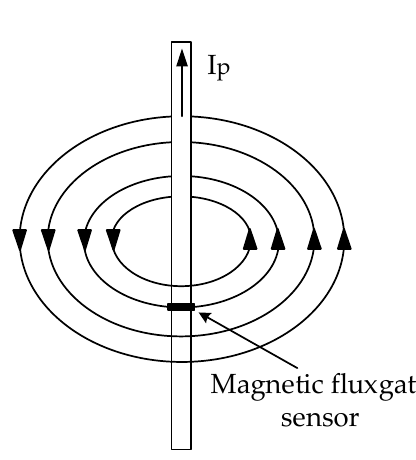
Figure 3. Fluxgate current measurement schematic.